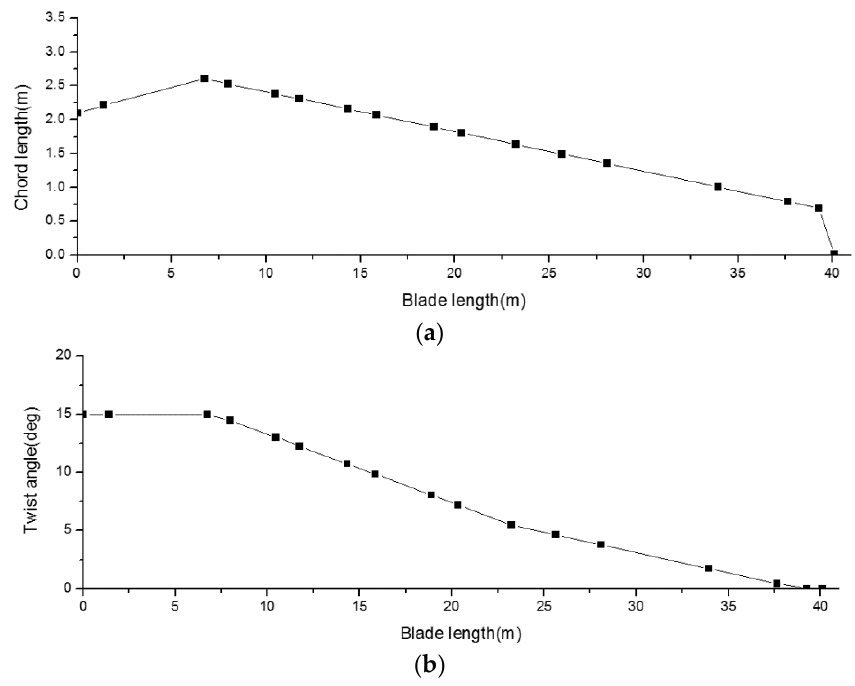
Figure 4. Baseline blade geometry. ( a ) Chord length distribution. ( b ) Twist angle distribution.